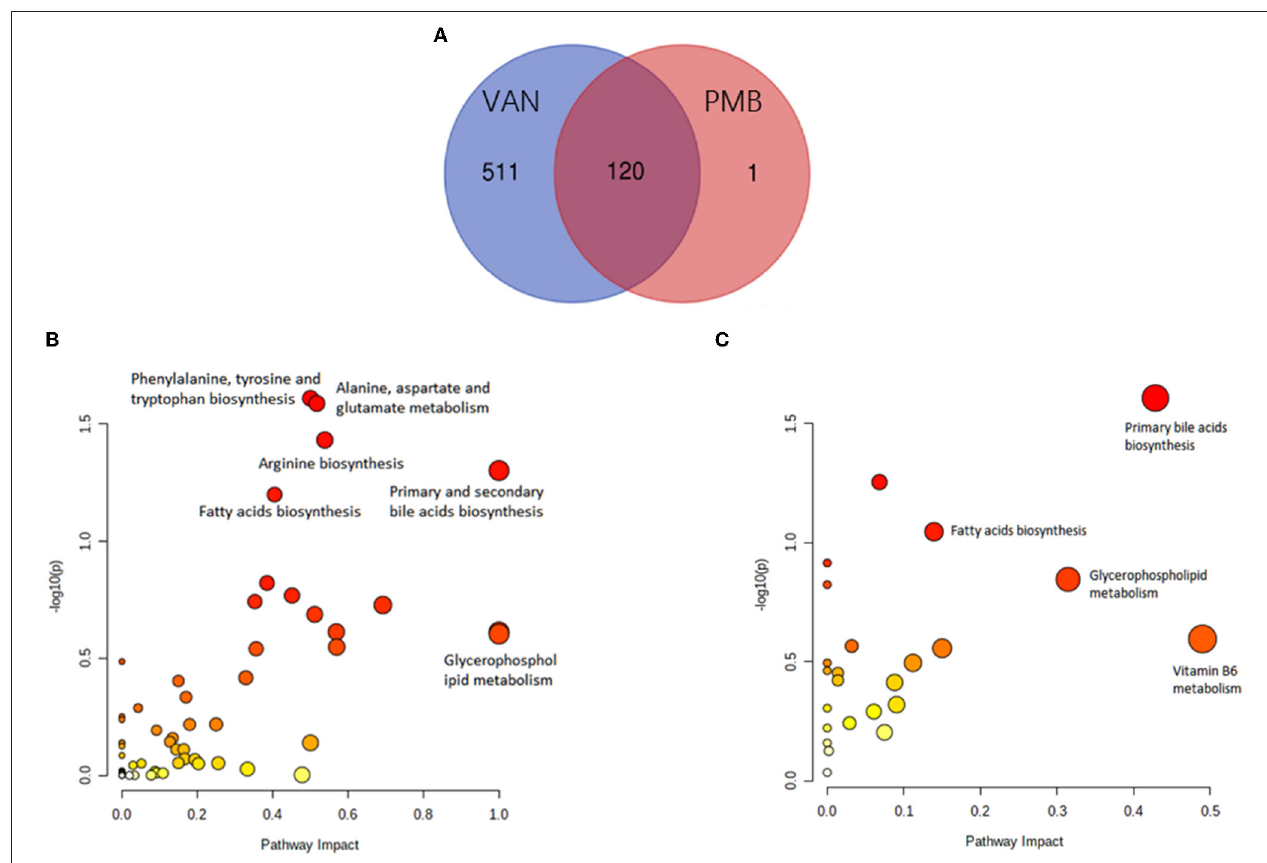
FIGURE 8 | Antibiotic-induced changes in metabolites. (A) The number of metabolites induced by VAN and PMB treatment in comparison with the baseline. The VAN- (B) and PMB- (C) induced metabolites change enriched in significant KEGG pathway. VAN, vancomycin; PMB, polymyxin B.